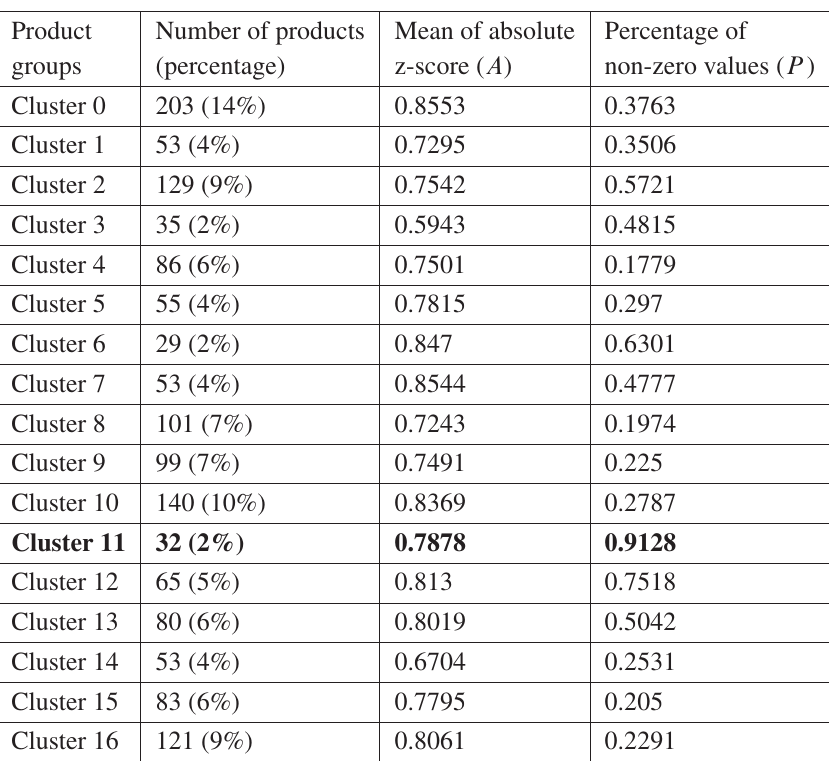
Table 9. Tier-2 weekly stability analysis with the EM algorithm in 2005.